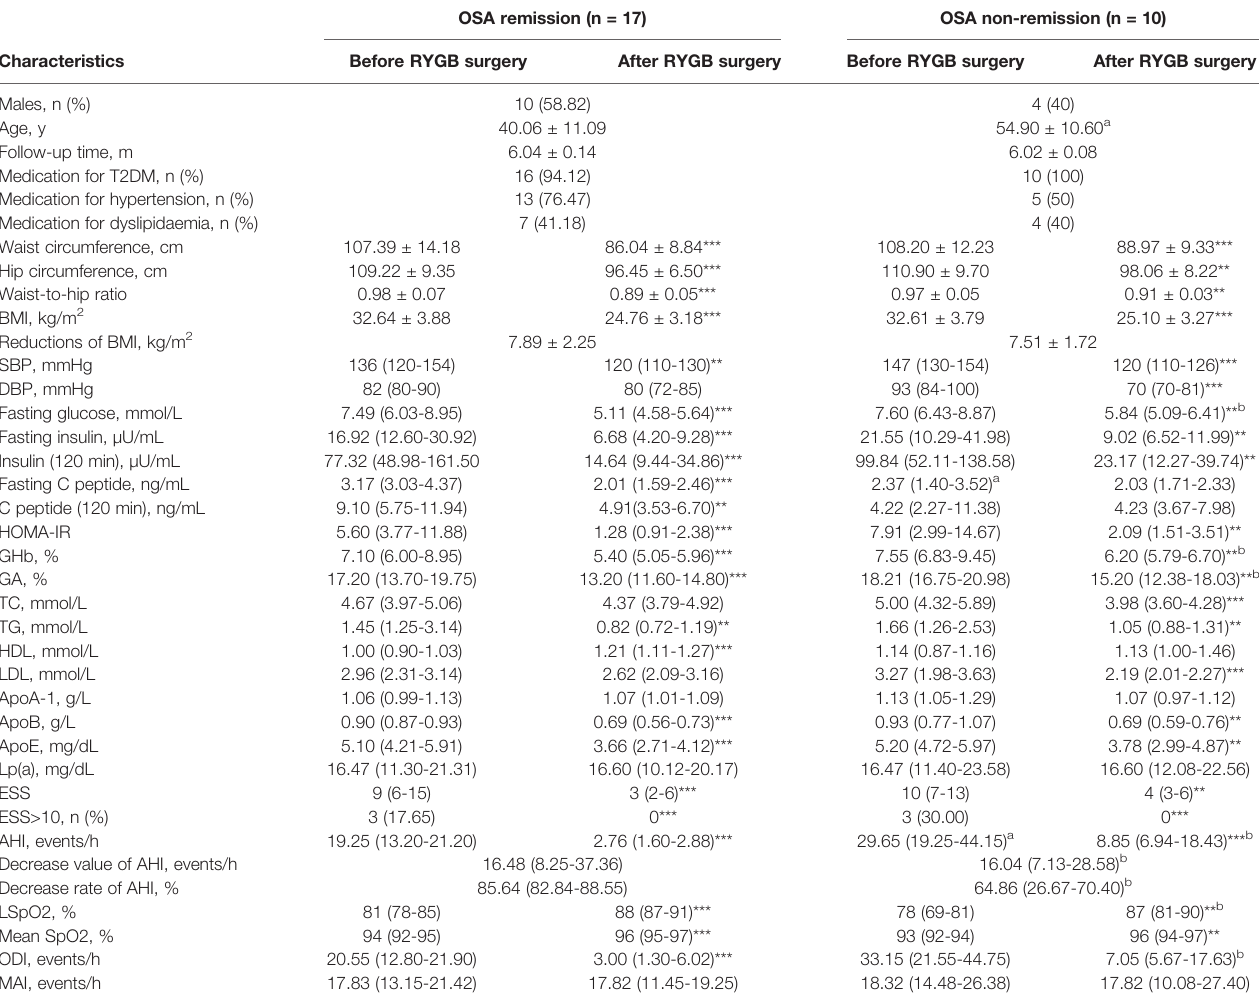
TABLE 2 | Clinical characteristics of the OSA remission and non-remission groups before and after RYGB surgery. OSA remission (n = 17) Characteristics Before RYGB surgery After RYGB surgery Before RYGB surgery